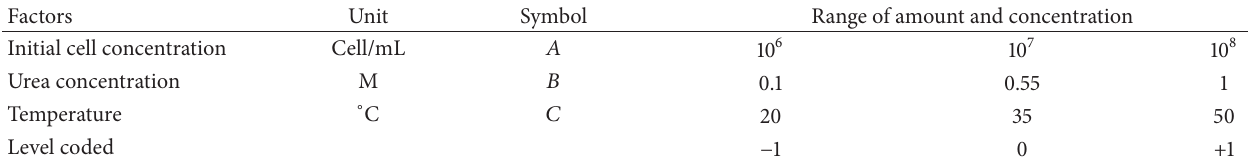
Table 1: Experimental range of amount and levels of the